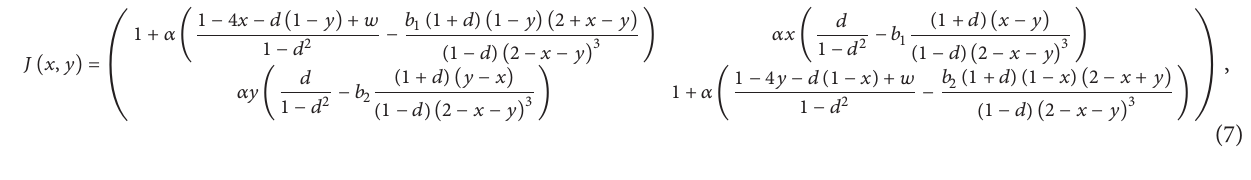
Figure 1: (a), (b). The feasible set 𝐷 ⊂ 𝑄 is depicted in white; the gray points are initial conditions producing unfeasible trajectories. (a) = 𝑏 = 0.2 . (b) 𝛼 = 1.5 , 𝑑 = −0.2 , 𝑤 = 0.5 , and 𝑏 𝛼 = 1.5 , 𝑑 = −0.1 , 𝑤 = 0.5 , and 𝑏 1 2 𝑇 and the parameter values as in (b). (d) Critical curves of rank-1, LC = 𝑇( LC separate the plane into the regions 𝑍 4 , 𝑍 2 , and 𝑍 0 , whose points have a different number of